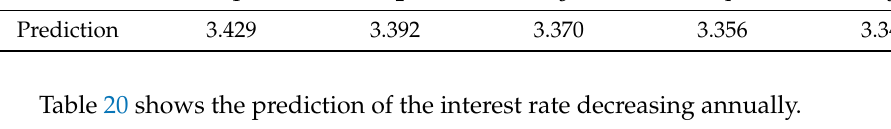
Table 20. Forecasting the interest rate at T = 1,2,3,4,5. Table 20. forecasting the interest rate at 𝑇 = 1,2,3,4,5